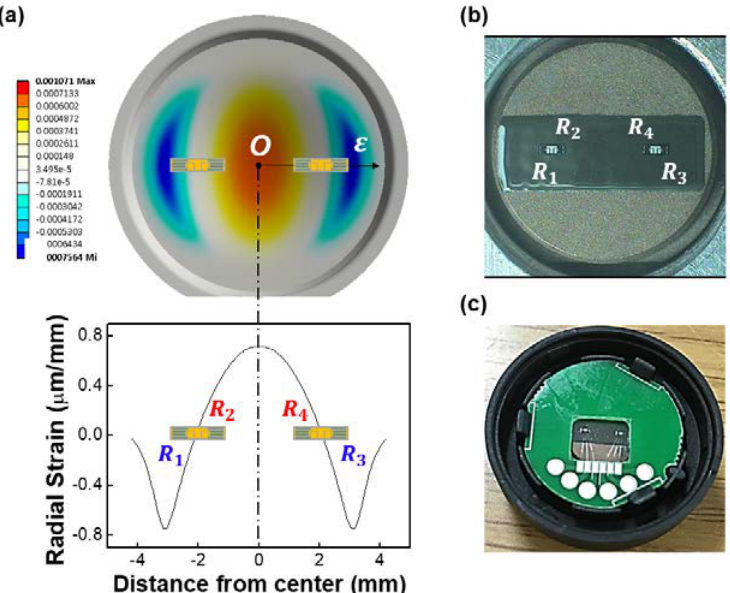
Figure 5. ( a ) Simulation result of the radial strain distribution in the metal diaphragm for each pressure loading condition by ANSYS software; ( b ) Si strain gauges bonded to metal diaphragm; ( c ) Al wire-bonded gauge chips assembled into the plastic package for measurements.